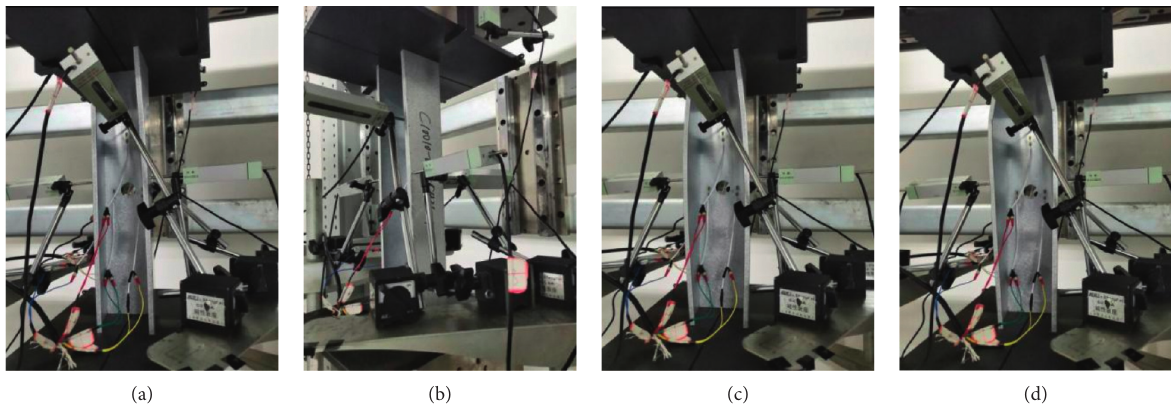
Figure 9: Buckling modes of the specimen C80-05-1H3-2. (a) Local buckling in the web. (b) Local buckling in flanges. (c) Distortional buckling. (d) Failure in interaction buckling.